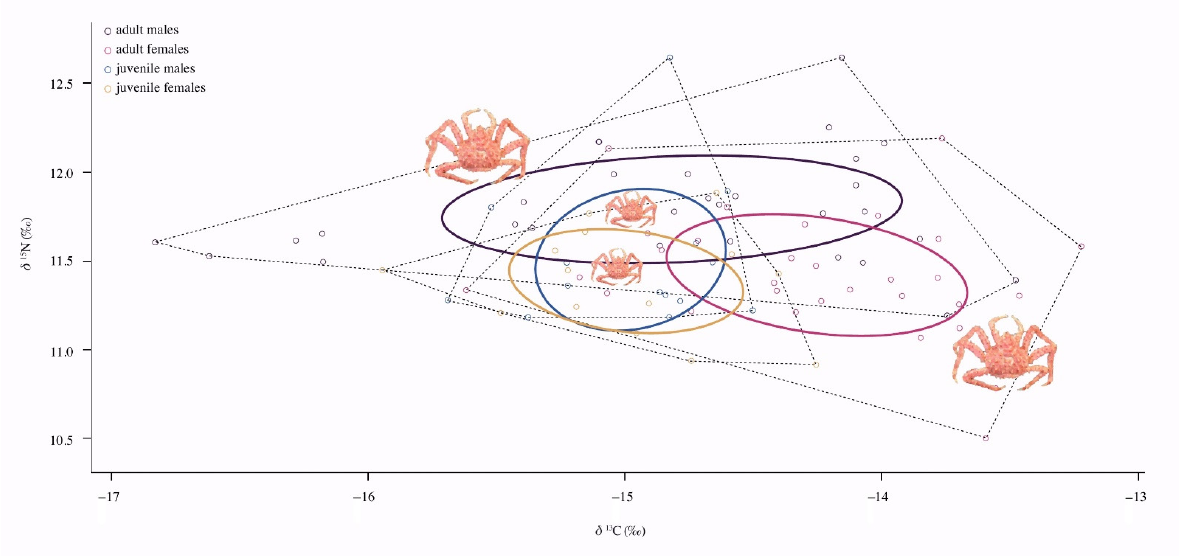
Figure 4. Isotopic niche widths of the southern king crab Lithodes santolla among sex and maturity stages in delta space. The standard ellipse areas (SEAs) are indicated by the solid lines, and convex hulls of the total area (TA) are indicated by the dashed lines estimated by SIBER analysis.